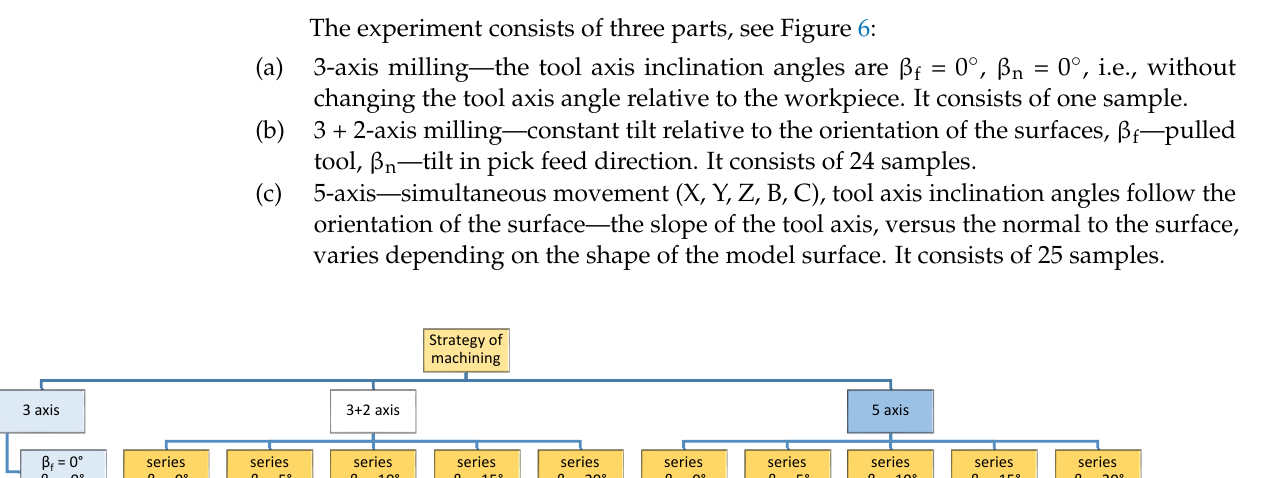
Figure 5. CAD geometry used in experiments (Surfaces: R2 mm—green, R5 mm—yellow, R6 mm—blue).